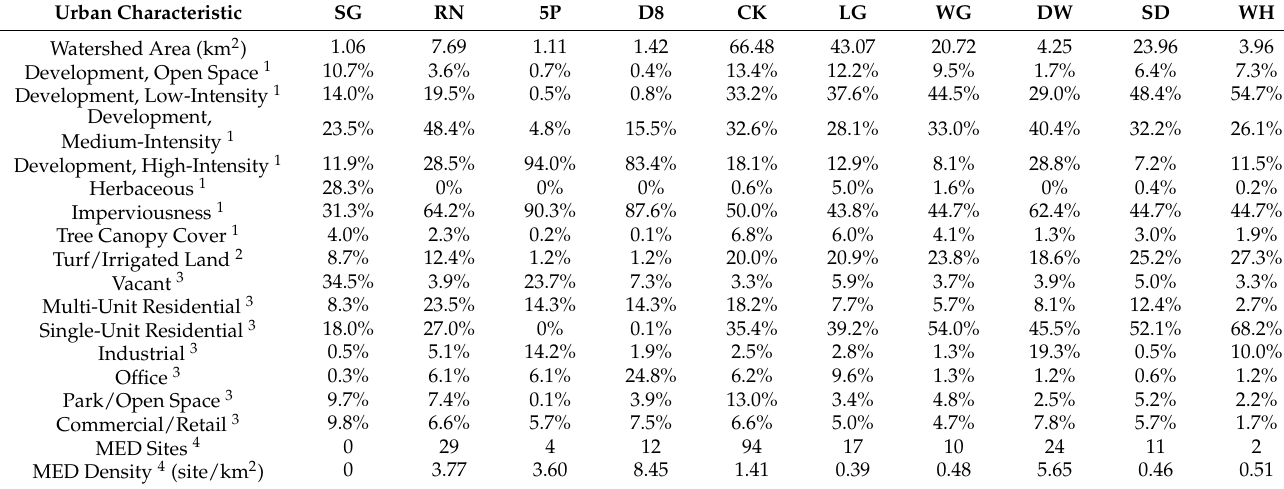
Table 3. Percentages of urban characteristics for each site. Sources for each characteristic are denoted in table